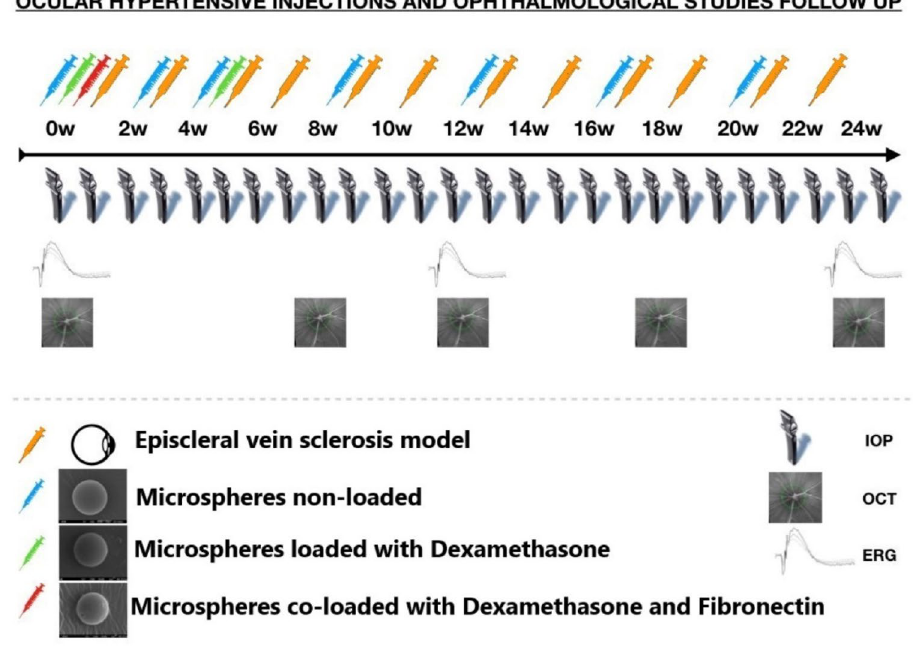
Figure 1. Ocular hypertensive injections and ophthalmological studies. IOP intraocular pressure; OCT optical coherence tomography; ERG electroretinography; w week. The microspheres external morphology images were obtained by scanning electron microscopy (Jeol, JSM-6335F, Tokyo, Japan). The rat optic nerve head images were adquired by Spectralis optical coherence tomography device (Heidelberg Engineering,